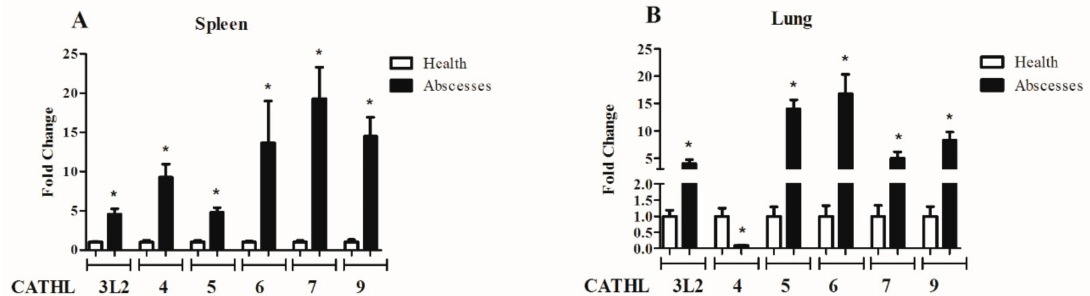
Figure 6. Comparison of the relative expression levels of cathelicidins in spleen ( A ) and lung ( B ) of healthy and purulent individuals. The relative gene expression was measured by real-time PCR using glyceraldehyde-3-phosphate dehydrogenase (GAPDH) as a reference gene. The bars represent the means ± standard error of mean (SEM). Di ff erences between the healthy and purulent groups were determined by an unpaired Student’s two-tailed t -test, and * indicates p <